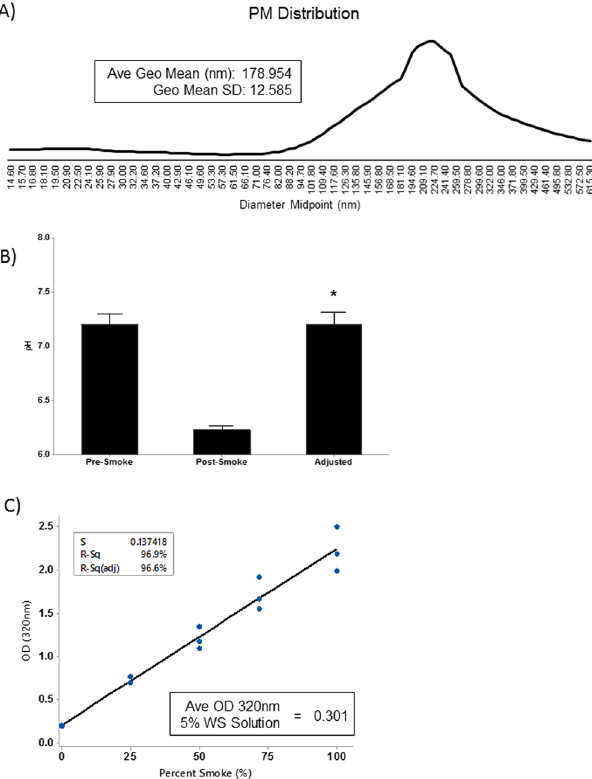
Figure 2. Characterization of Birch Wood Smoke and the Wood Smoke Infused Solution. ( A ) A representative distribution of the PM generated (nm) from the combustion of birch wood. The average geometric mean was 178.954 ± 12.585 nm. Data presented as mean ± SD. ( B ) The pH for PBS was assessed prior to, and following, WS infusion. pH of the resulting solution was adjusted to that prior to WS infusion. * P < 0 . 001 vs. pre-smoke and adjusted; n = 3. Statistical difference was determined by one way ANOVA followed by a Tukey’s post- hoc test. ( C ) Generation of a standard curve was accomplished by assessing the absorbance of the solution at 320 nm. Repeated measurements of WS infused PBS generated a highly reproducible curve (R 2 = 96.8%).